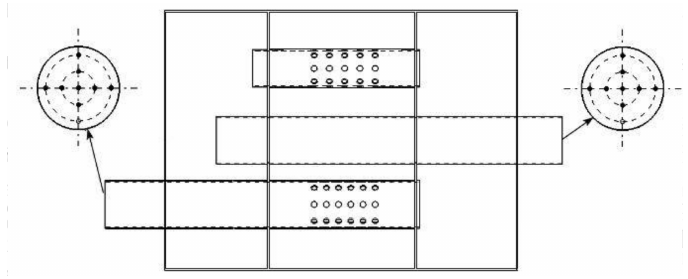
Figure 13. The selected points for the total pressure calculation in the cross sections of the inlet and outlet of the